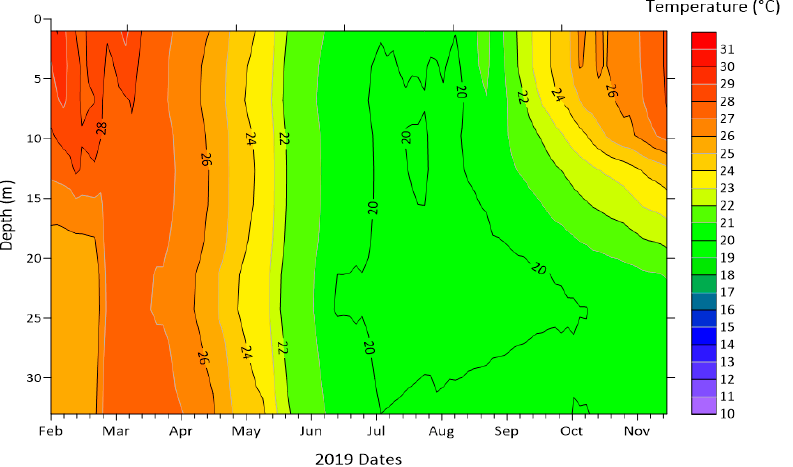
Figure 5. Temperatures in Bowen Lake 1 (February–November 2019) as measured by in situ continuous monitoring chains.